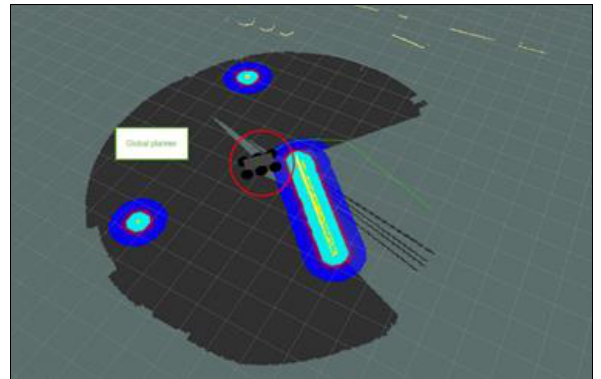
Figure 11. Performance of A* algorithm on a cost